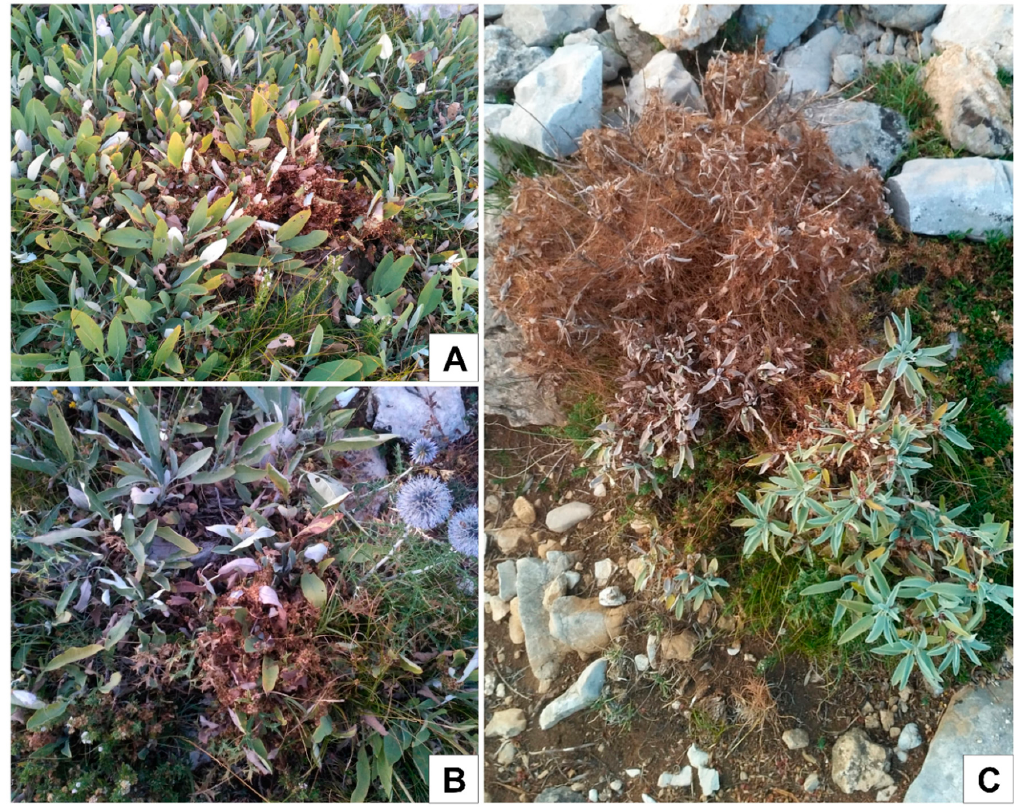
Figure 9. Cuscuta sp. on patches of S. brachyodon ( A ), and ( B ), and S. officinalis ( C ) within studied population.